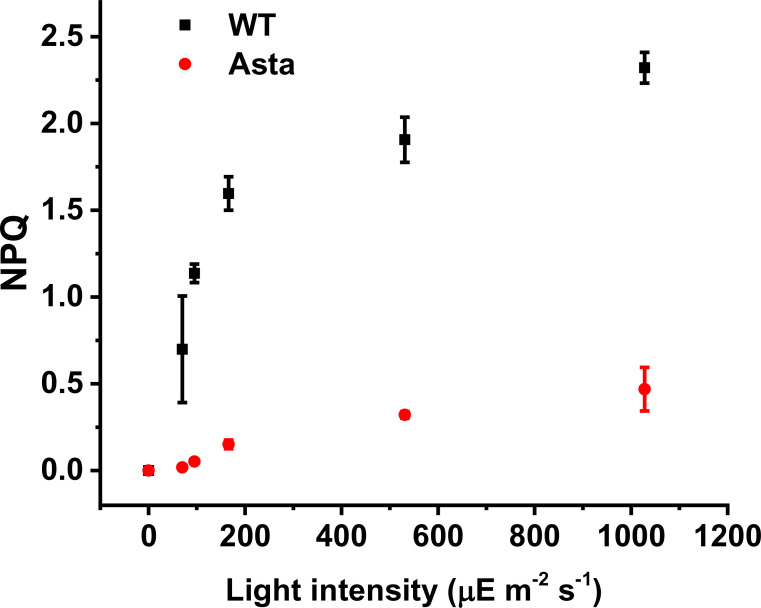
Light dependence of NPQ.Steady-state NPQ (10 min of illumination at each light intensity) is plotted as a function of actinic light intensity for both WT and Asta plants. Both lines show a similar sigmoidal shape of the NPQ capacity bar for the amplitude of light-induced NPQ, which is vastly decreased in mutant plants. (Average values ± SD are shown for n = 3 leaves/plants, biological replicas.).